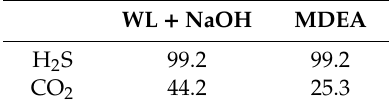
Table 11. E ffi ciencies of H 2 S and CO 2 cleaning in %. WL = white